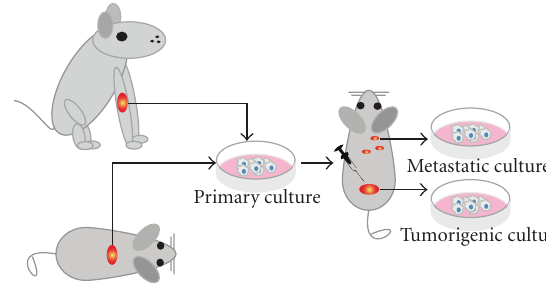
Figure 2: Animal cell lines. Schematic representation shows how cell cultures are established from spontaneous canine or murine osteosarcoma. After subsequent injections of the cells into mice, tumorigenic and/or metastatic cultures can be established from the tumors or the metastases, respectively. Please note that dissemina- tion of cells after cell injections is often referred to as metastasis; however, often it is not proved whether these cells are true metastases from a primary tumor or cells that migrated through the body after injection of the cell